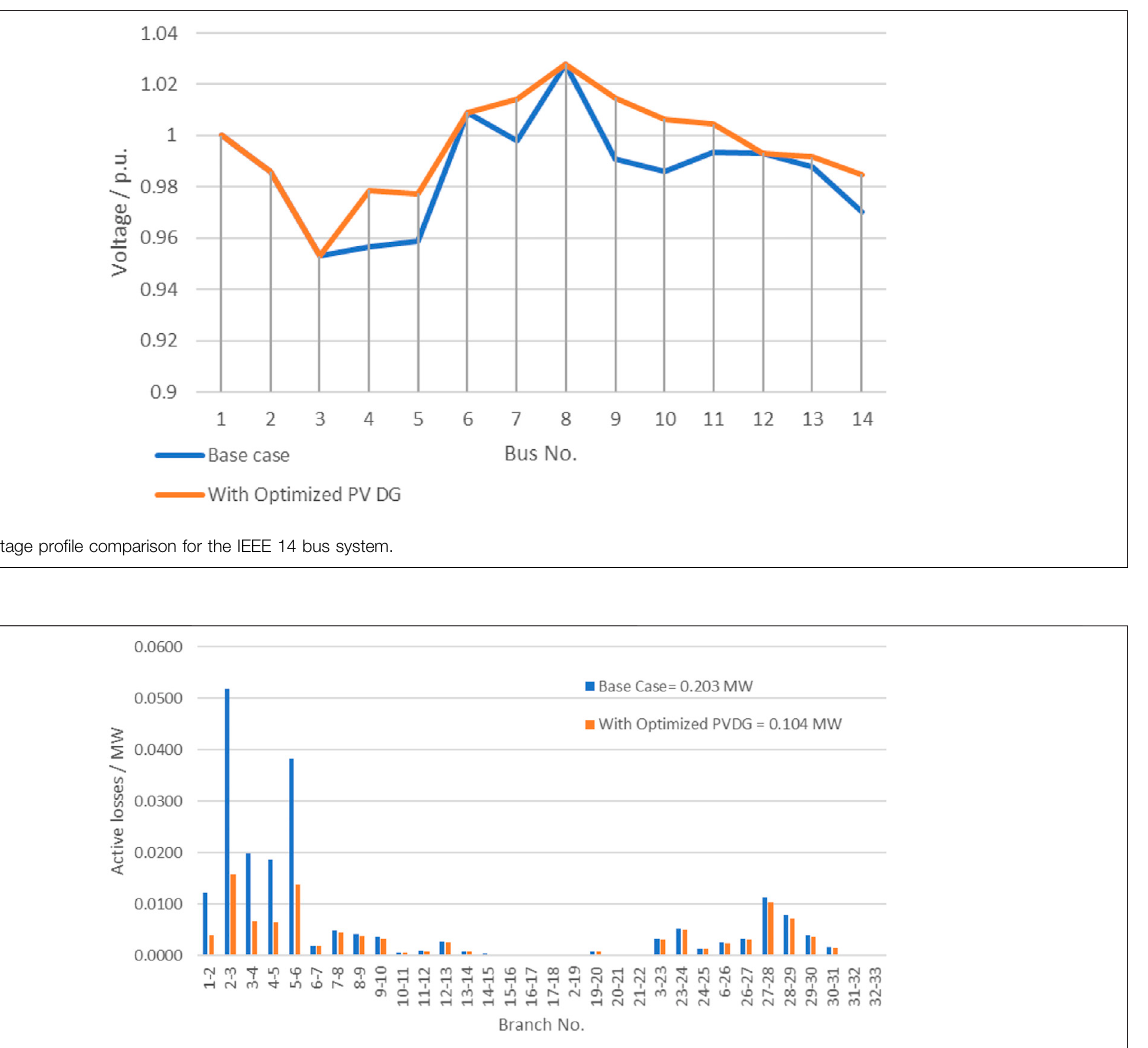
FIGURE 7 | System loss comparison for the IEEE 33 bus